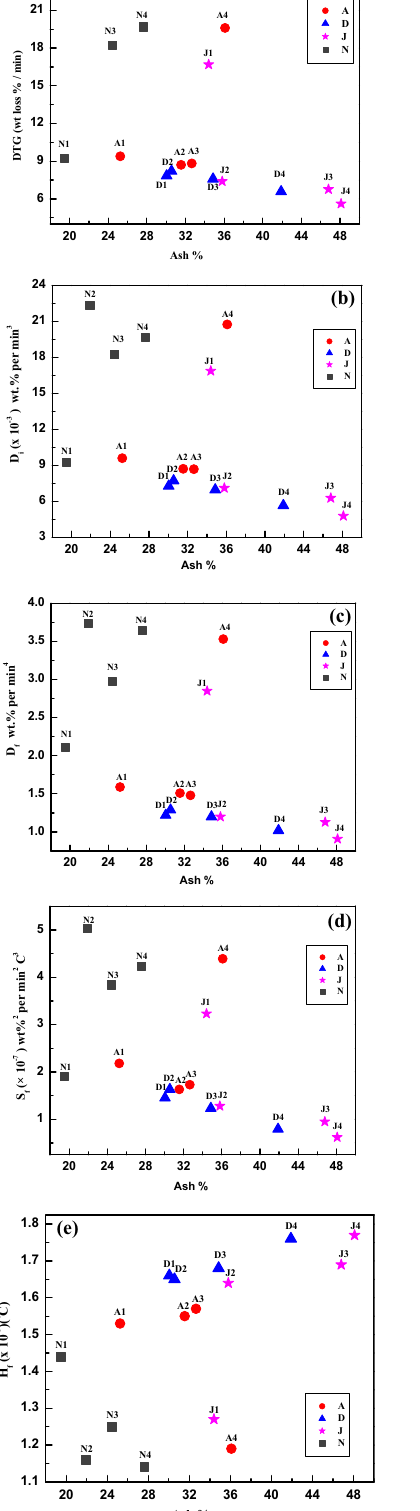
Fig. 2 Variation of combustion parameters: a DTG max , b D i , c D f , d S f , e H f with ash content